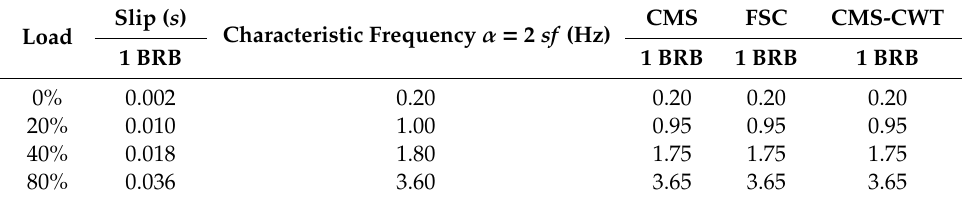
Table 3. The slips and characteristic frequencies under di ff erent